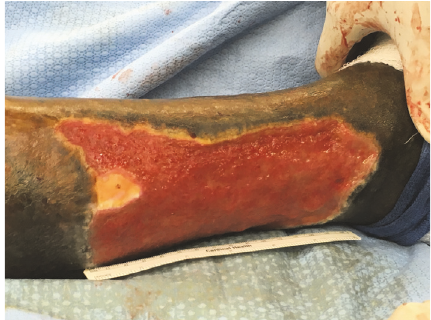
Figure 1: Right lateral leg venous stasis ulcer.